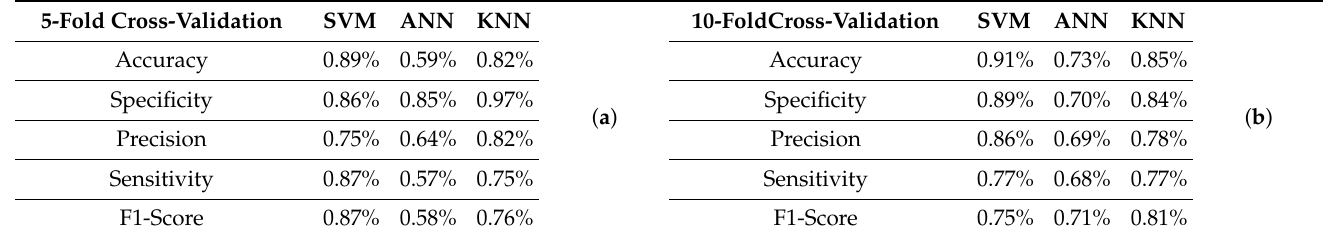
Table 3. ( a ) Results of 5-fold cross validation with GA. ( b ) Results of 10-fold cross validation with